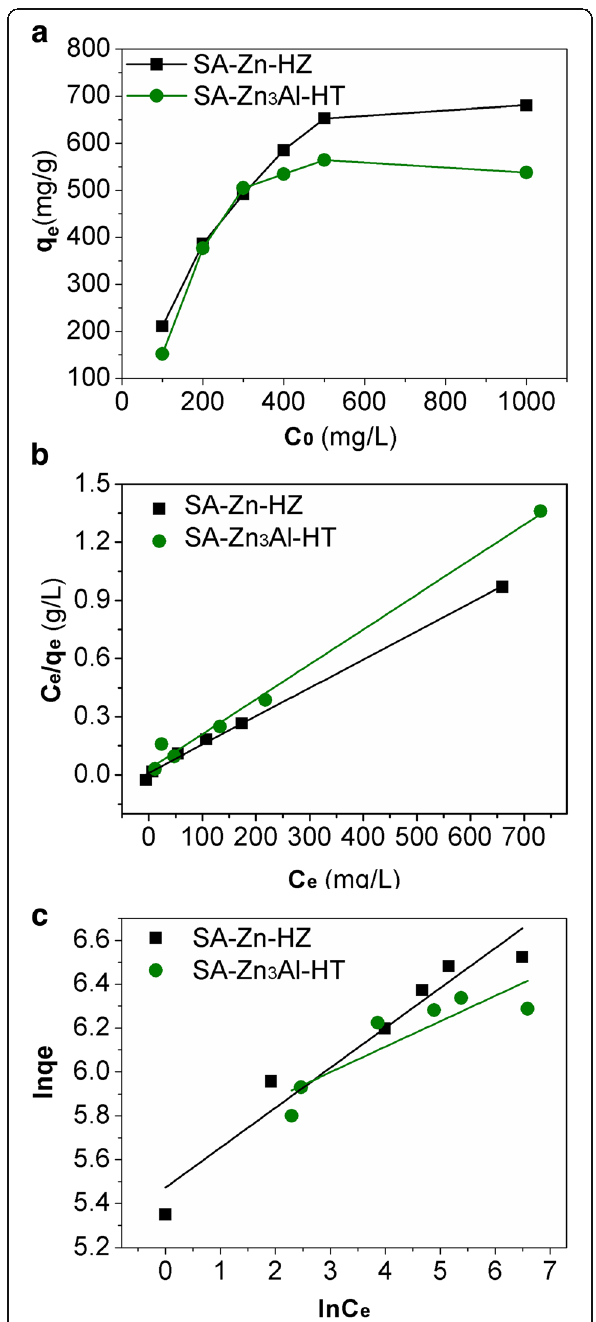
Fig. 4 Adsorption isotherms of Pb(II) on SA-Zn-HZ and SA-Zn 3 Al-HT ( a ), Langmuir ( b ), and Freundlich ( c ) adsorption isotherm models fitting for Pb(II) adsorption. Experiment conditions: initial Pb(II) concentration 100 ~ 1000 ppm; adsorbent dose 0.5 g L − 1 ; contact time 24 h, solution pH 6.0 ± 0.1; temperature 30